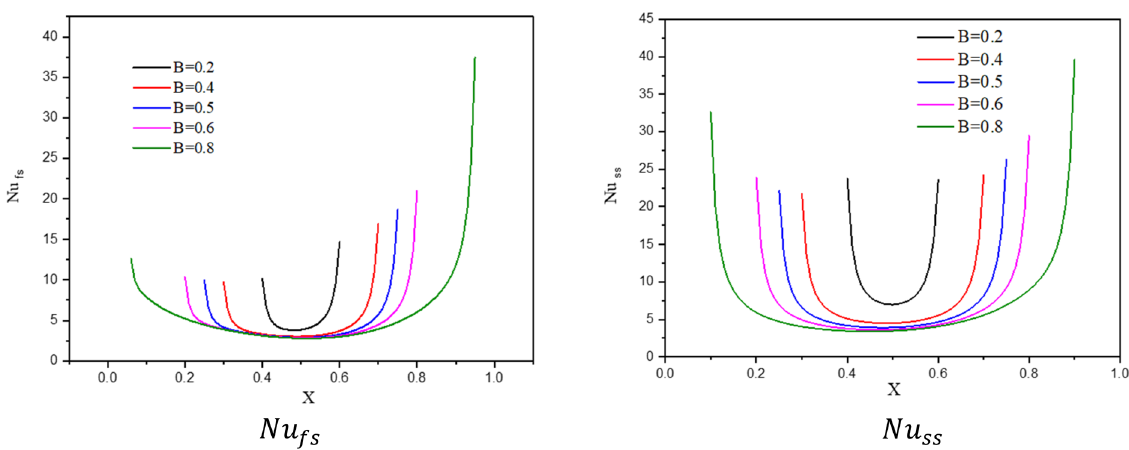
Figure 3. Profiles of Nu fs and Nu ss , below the changes on a partial heat length B for a hybrid nanofluid at φ Cu = φ TiO 2 = φ/ 2, φ = 0.05, Q = 1, R d = 0.5, ε = 0.5, Da = 10 D = 0.5, k r = 1, H ∗ = 10